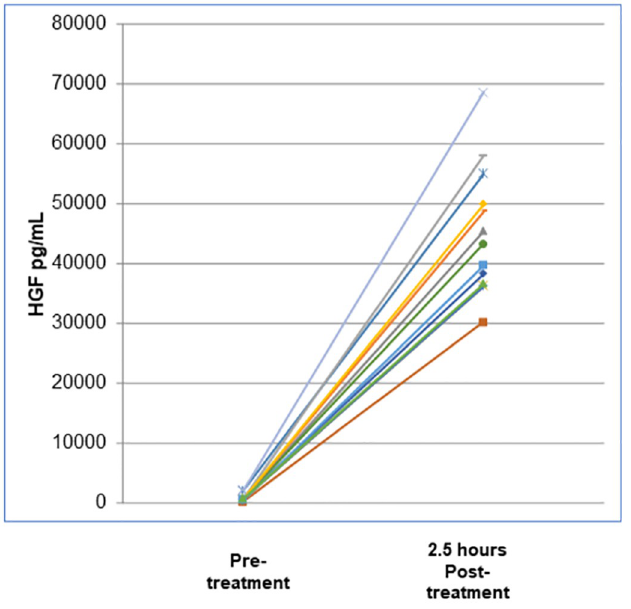
Fig 3. Post-injection changes in plasma HGF levels in individual patients after the Day 29 injection of ILB 1